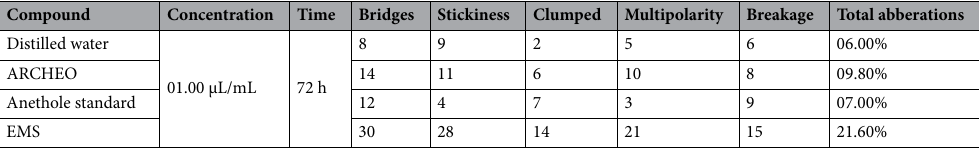
Table 8. Chromosomal aberration test for ARCHEO, anethole (standard) and EMS. ARCHEO anethole rich C. heptaphylla essential oil, EMS ethyl methanesulphonate.